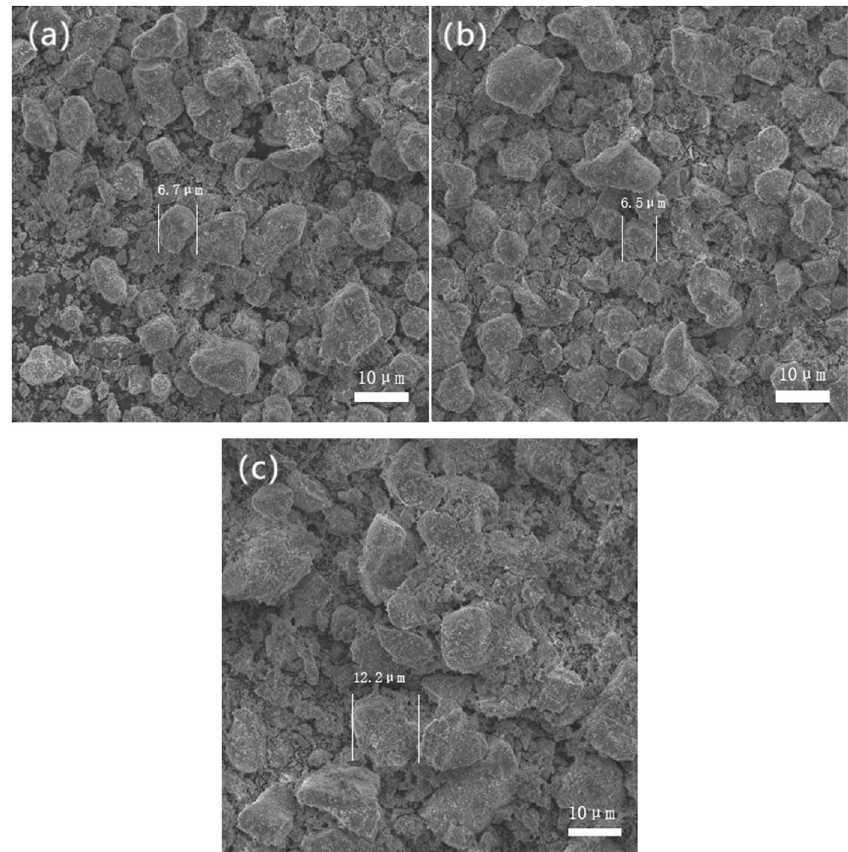
Figure 4: SEM images of KBaPO 4 :0.001Eu 2 + , y Sm 3 + ( y = 0 ( a ) , 0.12 ( b ) ,0.15 ( c ))